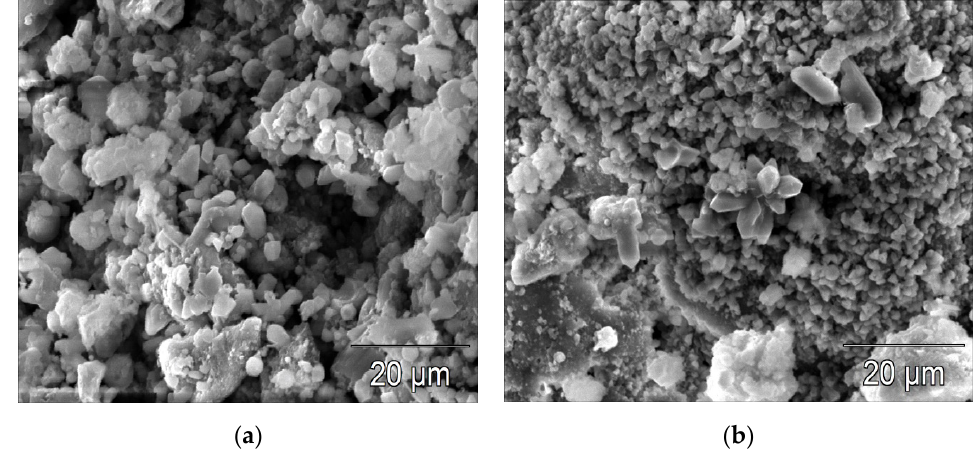
Figure 14. ( a ) SEM image of the 3H0 sample after seawater attack; ( b ) SEM image of the 3H6 sample after seawater attack.